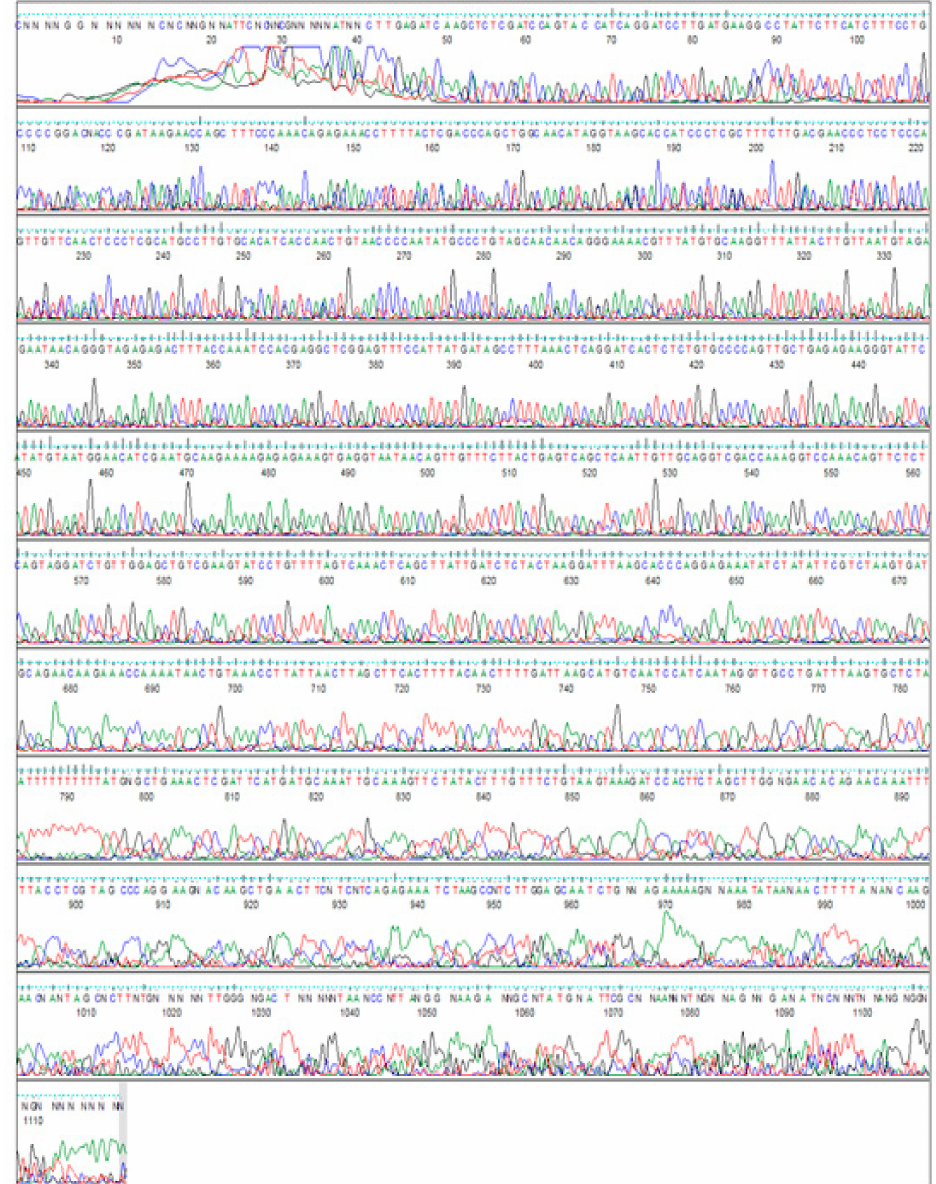
Figure 5. Gene sequencing of the glyoxalase I , a salt tolerance gene from Jojoba ( Jo-Glo1 ), by reverse primer